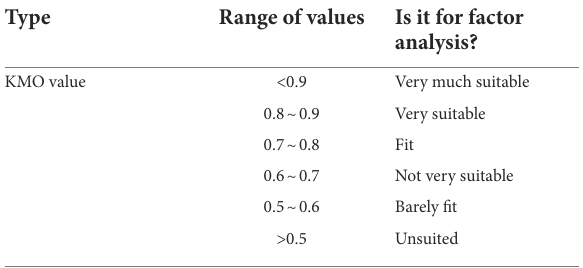
TABLE 2 KMO measurement standards.